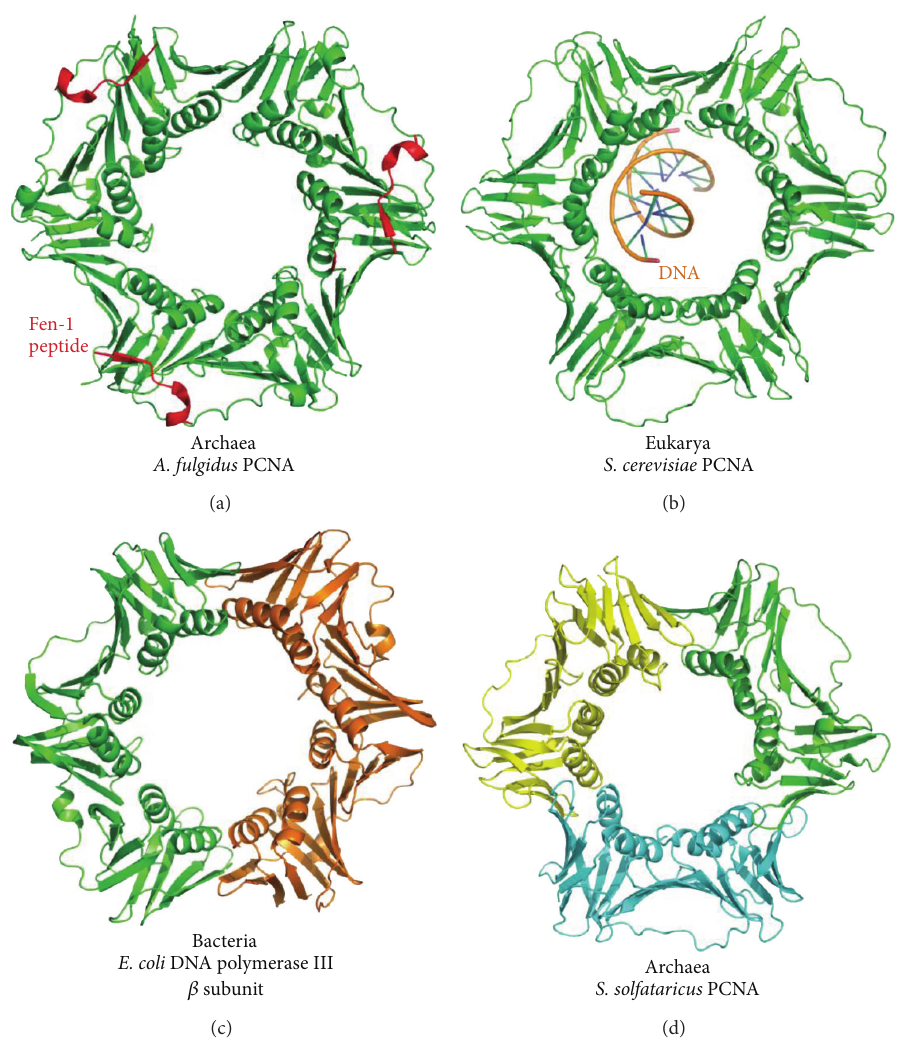
Figure 1: Comparison of PCNAs. The semblance of DNA sliding clamp proteins is made of differing general assemblies. (a) Archaeal A. fulgidus PCNA is a trimer composed of three identical subunits, which is the general case for PCNA proteins found in both archaea and eukaryotes. This particular structure has a FEN-1 peptide bound to each subunit (PDB code 1RXZ). PCNA proteins dock other enzymes to bring them into proximity to DNA when their functions are required. (b) The S. cerevisiae PCNA shares the general homotrimer assembly with other archaeal and eukaryotic PCNA proteins (PDB code 3K4X). This particular structure was engineered such that a DNA molecule was sequestered within the ring. (c) The 𝛽 subunit of bacterial DNA polymerase III complexes shares the PCNA fold with its archaeal and eukaryotic counterparts. However, the assembly is formed by a homodimer (PDB code 2POL). (d) Archaeal S. solfataricus PCNA is unusual as it is assembled as a heterotrimer (PDB code 2HIK). It perhaps evolved this way to dock different enzymes with